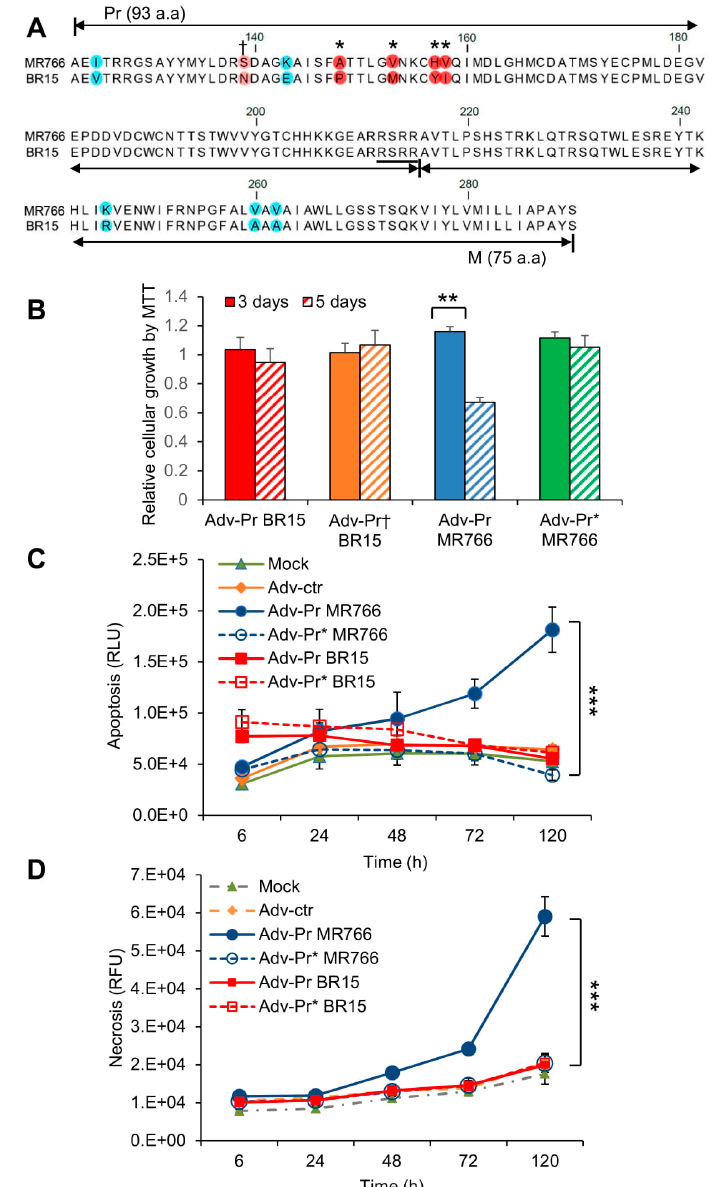
Figure 6. Mutational analysis of the Pr region of the prM protein. ( A ) Mutagenesis of the Pr protein. Four amino acids mutations (A148P, V153M, H157Y and V158I) were generated as shown by “*” on the top of the prM sequence alignments between MR766 (top) and BR15 (bottom). The resulting mutant adenoviral construct is labeled as Adv-Pr* MR766 . The site of the reverse N139S mutation is shown by “†” on the top of the prM sequence. The corresponding mutant adenoviral construct is labeled as Adv-Pr †BR15 . ( B ) Cell proliferation and viability by the MTT assay. Only Adv-prM showed significant differences overtime with p < 0.05 (**). Adv-Pr-induced cell death was measured by ( C ) apoptosis, and ( D ) necrosis over time. The underlined RSRR sequence indicates the putative furin cleavage site on the prM protein, based on its consensus target site Arg-X-Lys/Arg-Arg ↓ , where the arrow indicates the location of furin cleavage site. Two-way ANOVA was used to calculate the differences between Adv-prM and Adv-M for ( C ) and ( D ). The differences between Adv-Pr MR766 and Adv-Pr* MR766 were highly significant with p < 0.01 (***). However, the difference between Adv-Pr BR15 and Adv-Pr† BR15 was not significant with p > 0.99 for both apoptosis and necrosis. All quantitative results represent average and standard deviation (X ±